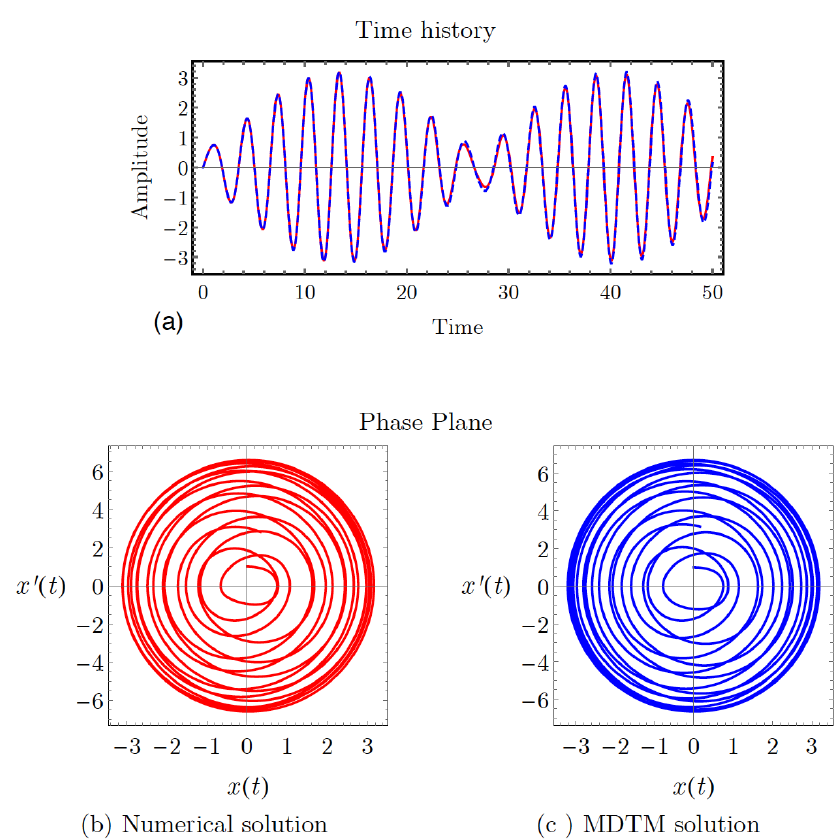
Figure 9. Red plot is the numerical solution and the blue plot is the Padé approximant solution of order [6/6] given by Equation